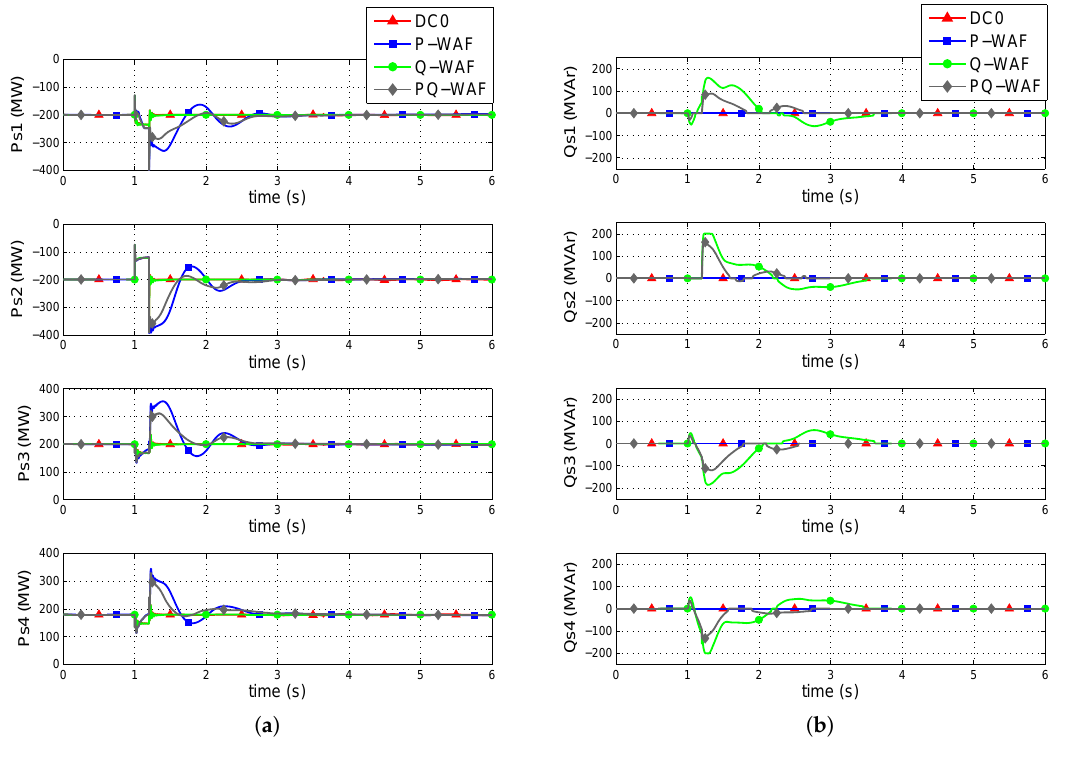
Figure 10. ( a ) P and ( b ) Q injections of the